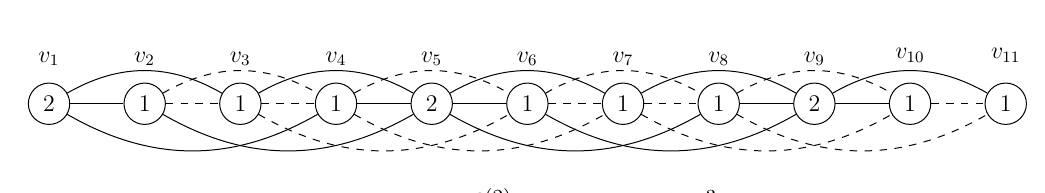
Figure 2 δ (2) -colouring of P 3